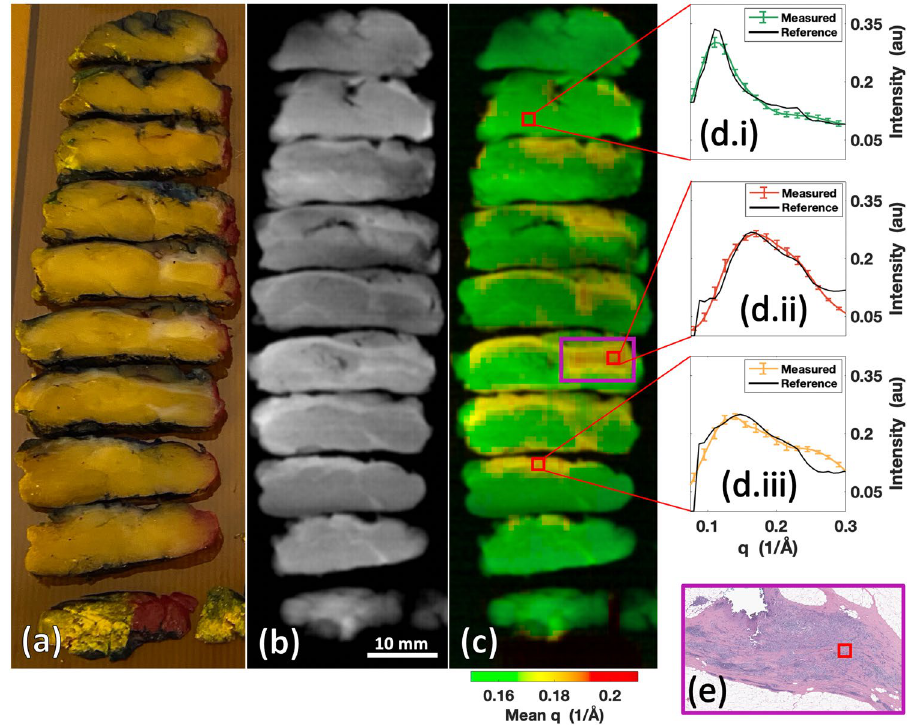
Figure 6. Malignant breast lumpectomy scanned by the X-ray fan beam coded aperture imaging system. ( a ) Photograph of the formalin-fixed and 5 mm thick sliced breast tissue. ( b ) Transmission scan of the breast tissue. ( c ) Combined transmission + mean q colorization (TQC) image of the breast tissue, with mean momentum transfer (q) color highlighting different tissue regions. ( d ) XRD spectra corresponding to voxels at marked locations in ( c ), with references (black lines) derived from literature 28 of ( d.i ) 65% adipose + 35% fibroglandular, ( d.ii ) 100% cancer, and ( d.iii ) 100% fibroglandular. ( e ) Pathology H&E slide for region of purple box in ( c ), where pathologist confirmed cancerous cells are present. The red square notes where the XRD spectrum was pulled for display in ( d.ii